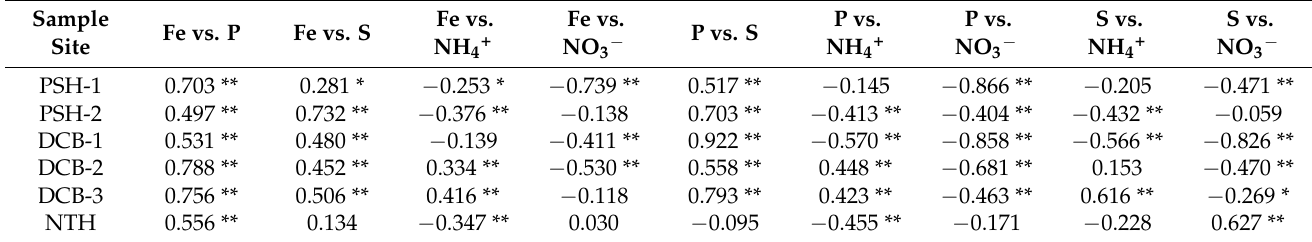
Table 3. Pearson correlation values between labile Fe, P, S, NH 4+ , and NO 3 − .